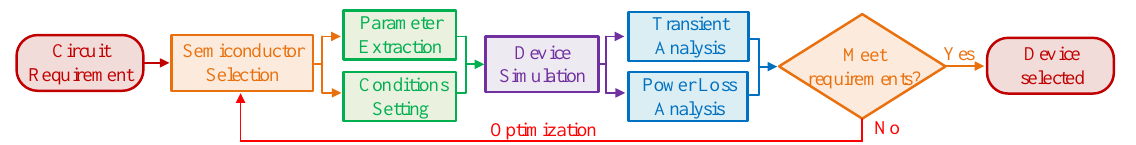
Figure 2. Flow chart of the proposed modelling procedure.